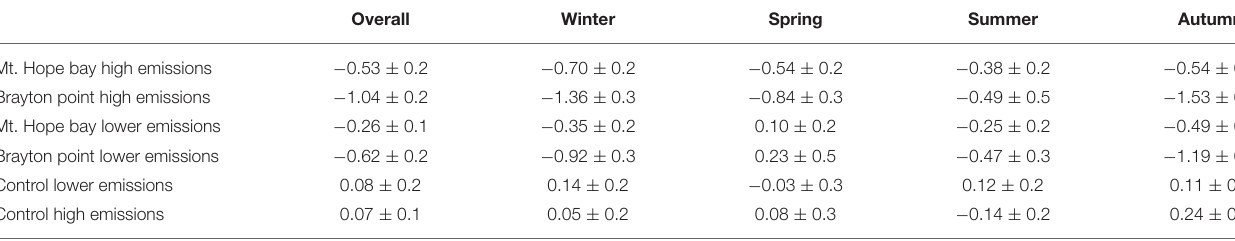
TABLE 2 | Temperature change in ◦ C in Mt.0Hope Bay, Brayton Point, and Upper Narragansett Bay (control). Overall Winter Spring Summer Autumn